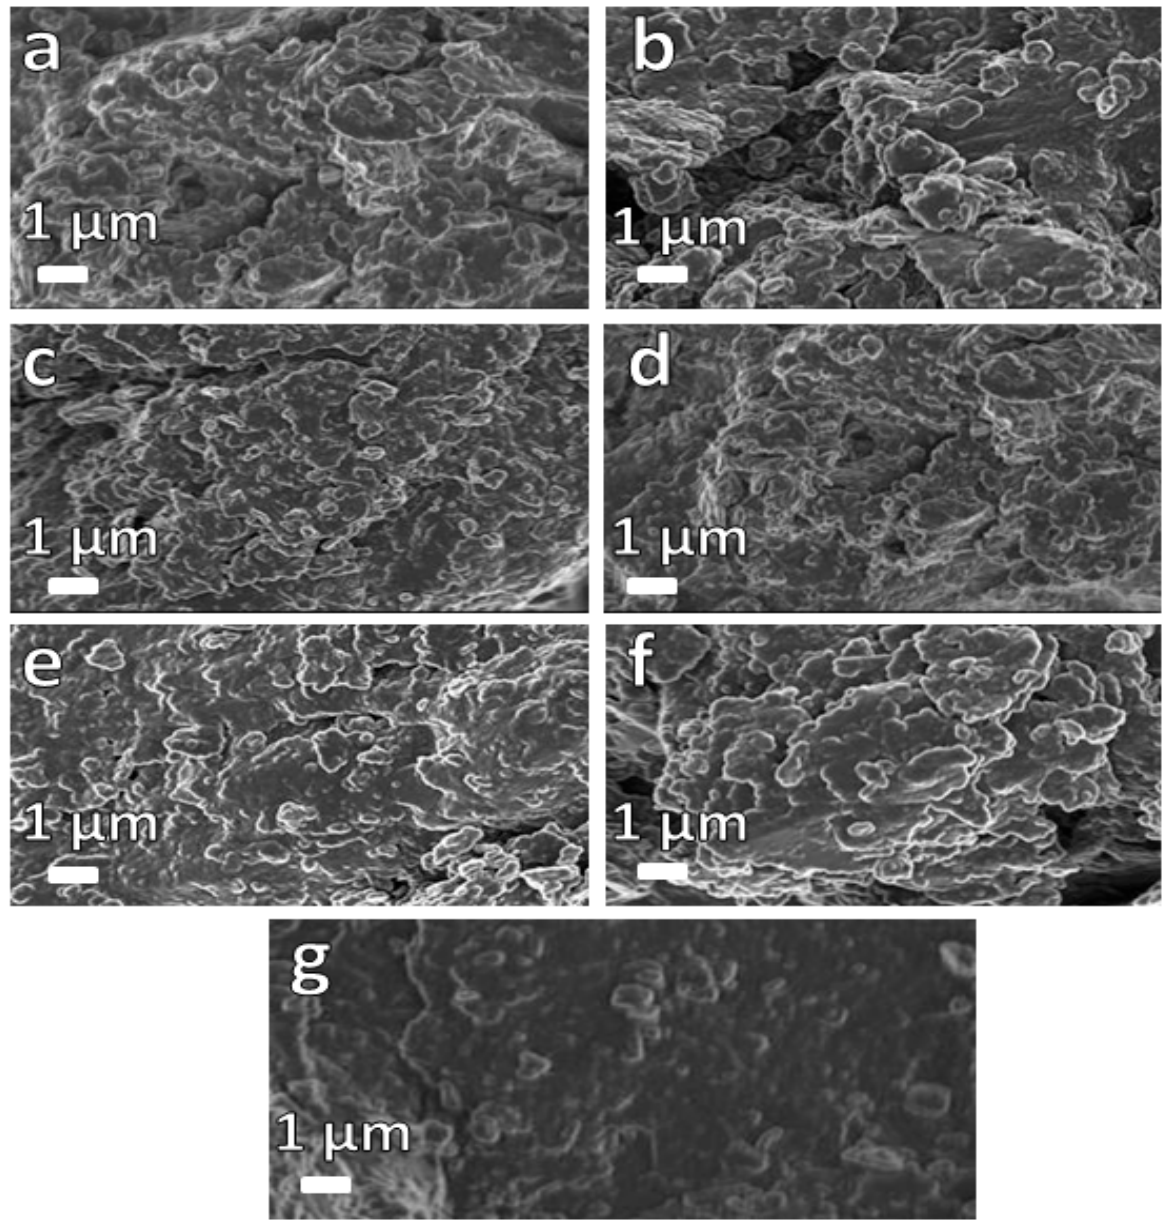
Figure 4. SEM Micrographs of the Sample: ( a ), ( b ), ( c ), ( d ), ( e ), ( f ) and ( g ), respectively.